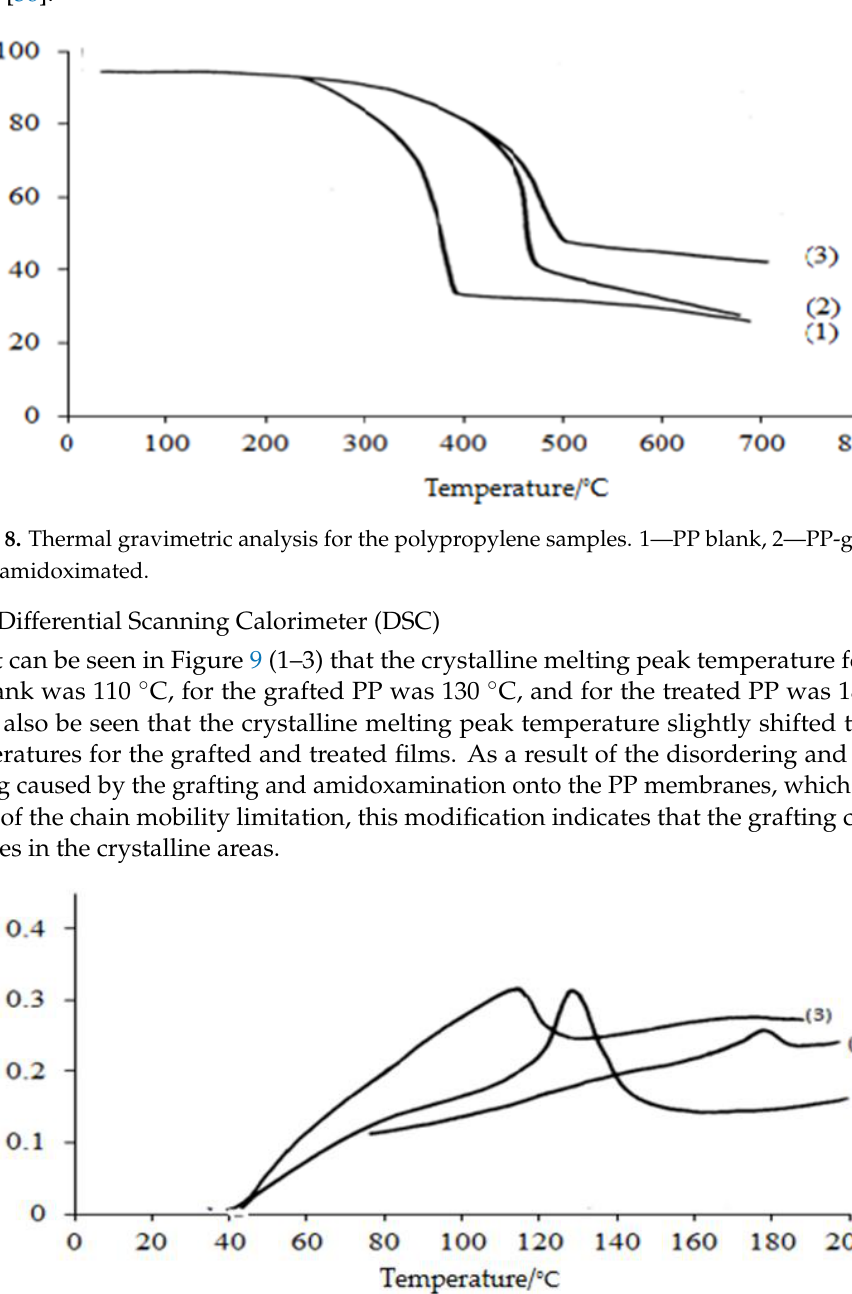
Figure 7. Effect of the degree of grafting on ( a ) the tensile strength and ( b ) the % elongation at the break on PP.